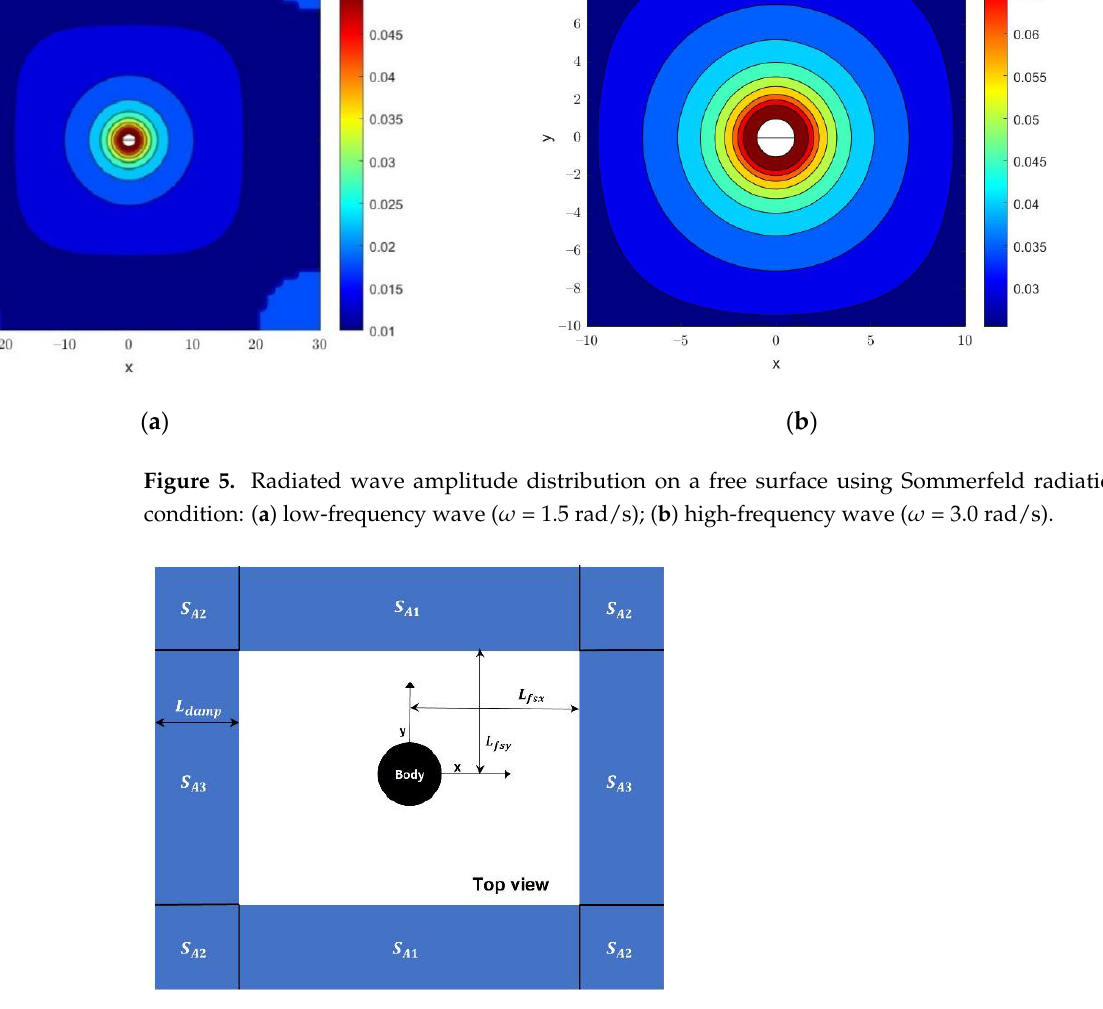
Figure 6. Plan view of FR-NWT domain applying artificial damping zones (blue: artificial damping zone). Table 2. Free surface boundary conditions with two different types of artificial damping terms.